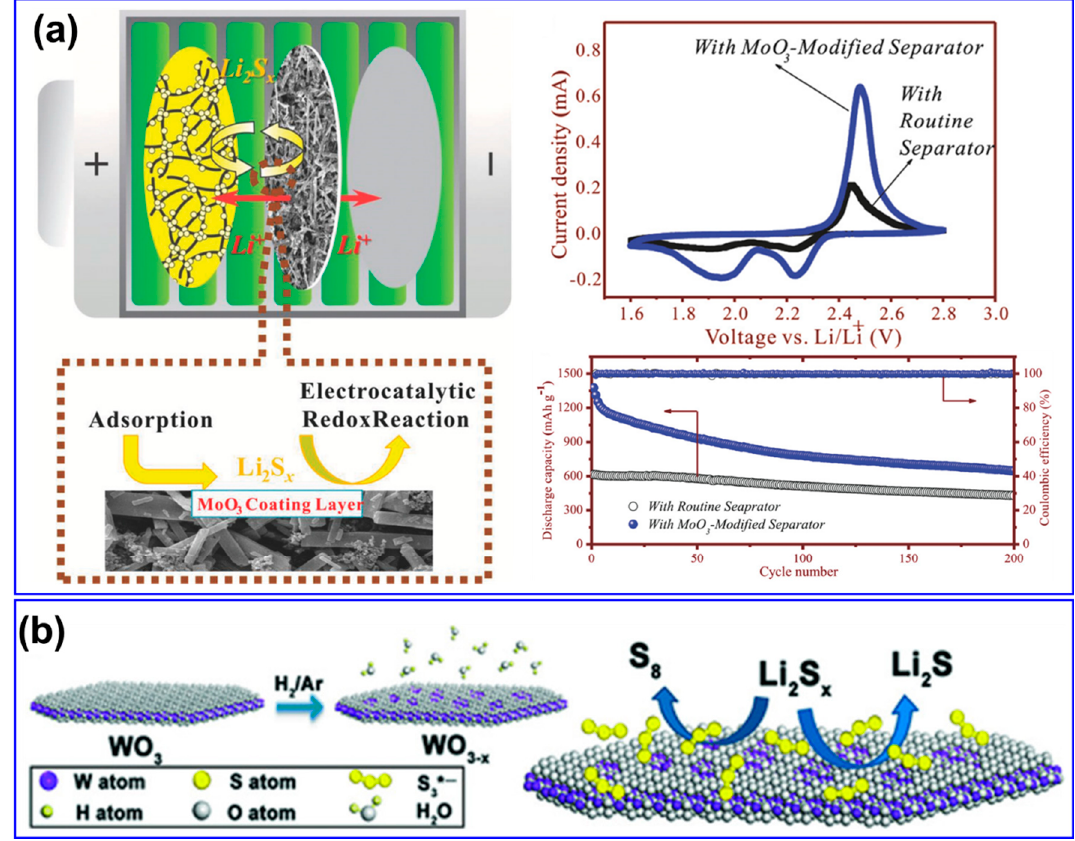
Figure 5. ( a ) Left: Schematic of the MoO 3 modified separator configuration in Li-S batteries. Right top and bottom: CV curves and cycling performance of Li-S battery with and without MoO 3 modified separator. Reproduced with permission, Copyright 2018, Wiley [80]. ( b ) Top: Schematic illustration of the synthesis of WO 3 and oxygen-deficient WO 3 and the conversion mechanism of Li 2 S x on the WO 3 − x surface. Reproduced with permission, Copyright, 2018, Wiley